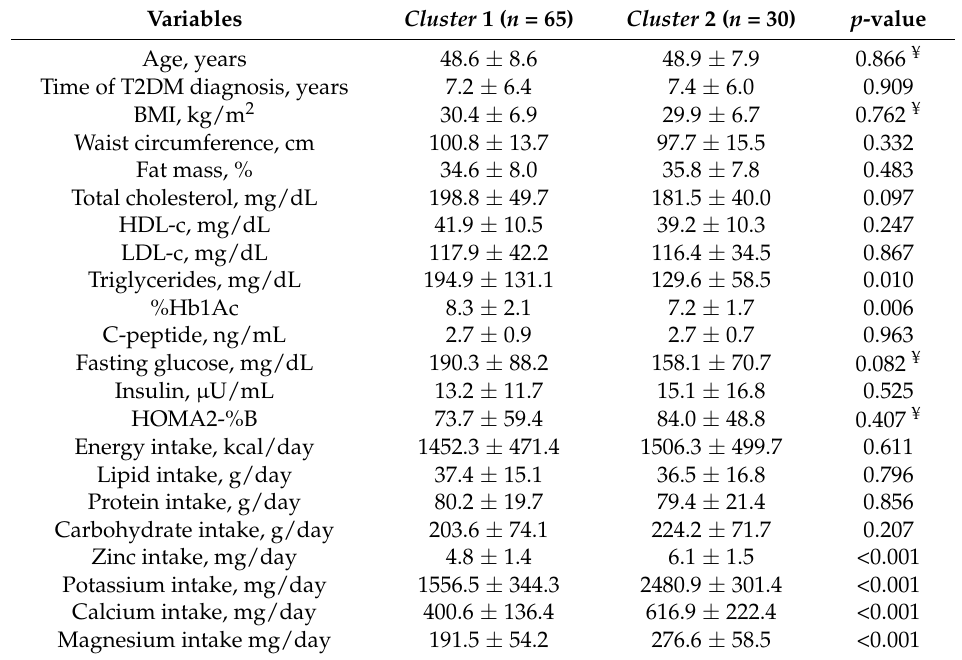
Table 2. Clinical, biochemical and nutrient intake variables of individuals with type 2 diabetes mellitus (T2DM).